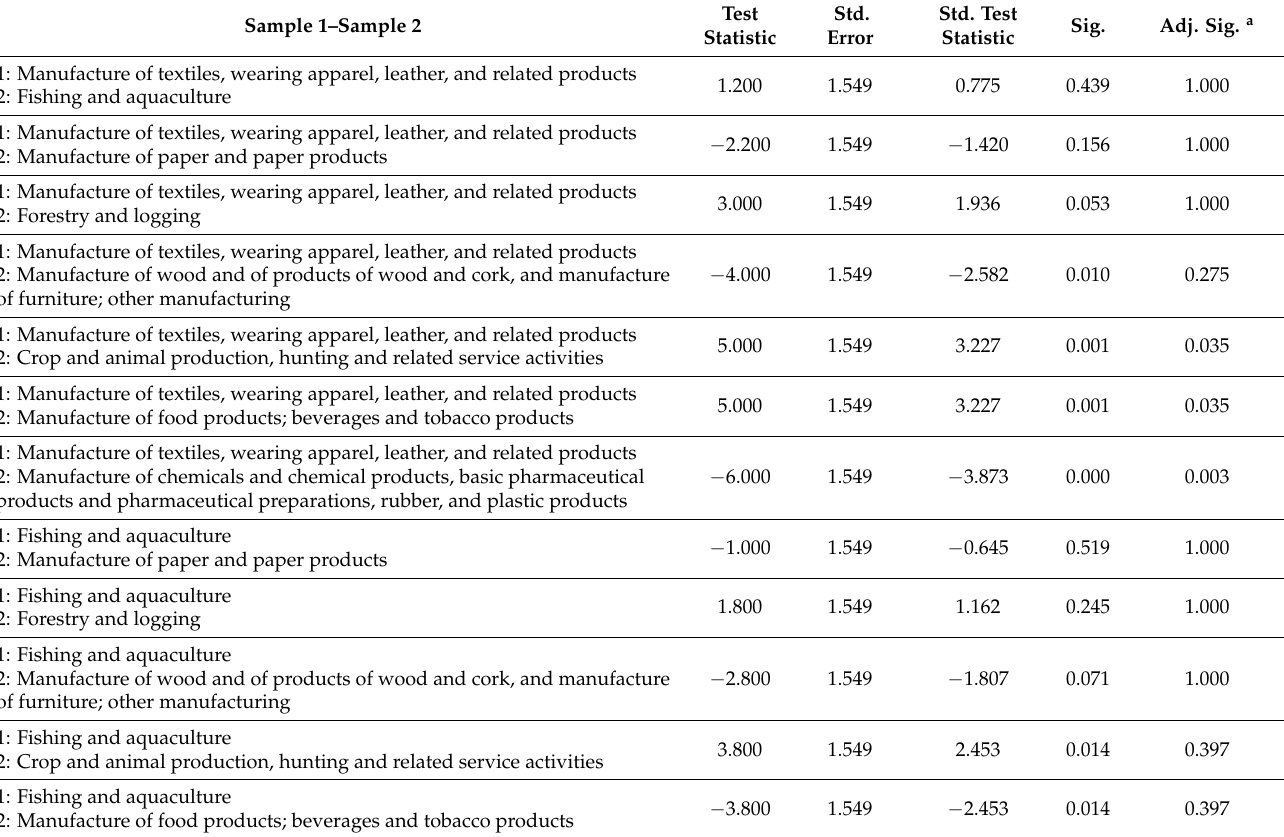
Table 3. Pairwise comparisons of economic performance across Nordic Bioeconomy Sectors